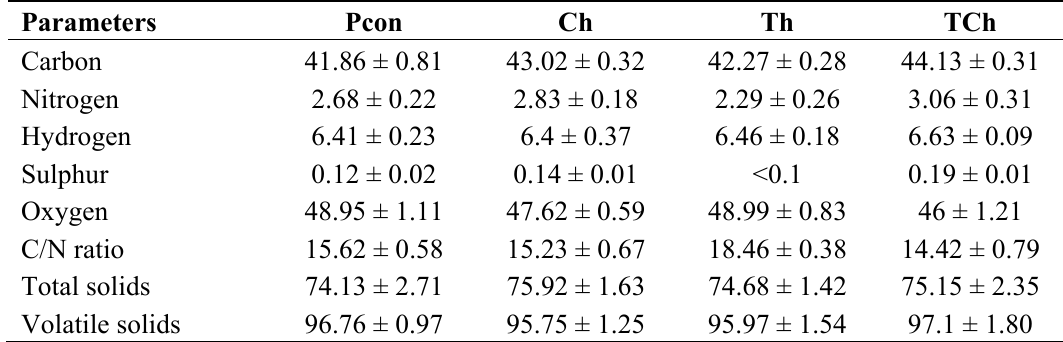
Table 3. Characteristics of residual solids of CRFW